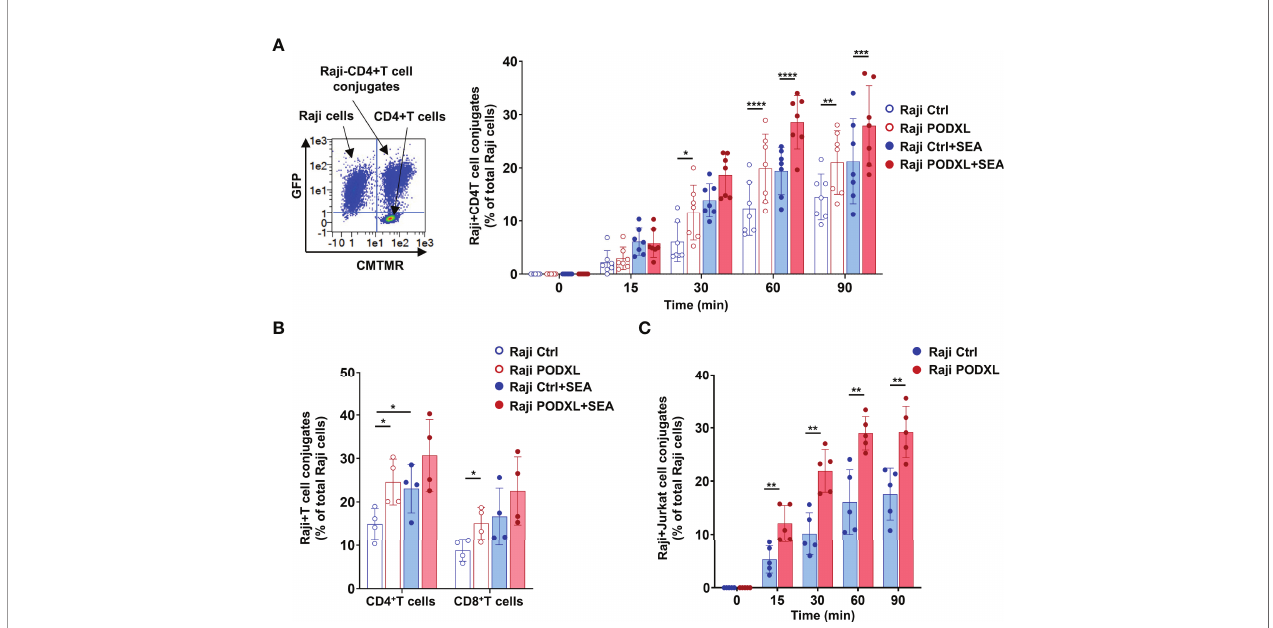
FIGURE 4 | PODXL expressed in APCs enhances both APC-CD4 + T cell and APC-CD8 + T cell interactions. (A) Raji cells overexpressing PODXL (red) or Raji-Ctrl cells (blue) were pulsed or not with SEA. Afterwards, CD4 + T cells isolated from PBMCs and pre-labelled with CMTMR were mixed with Raji-PODXL or Raji-Ctrl at a ratio of 1:1 and incubated for different time points at 37°C. The formation of conjugates between Raji cells (GFP + ) and CD4 + T cells (CMTMR + ) was detected as CMTMR + and GFP + events by fl ow cytometry. A representative density plot out of seven independent experiments is shown. Graph shows mean ± SD of the percentage of conjugates (CMTMR + GFP + ) from the total Raji cells (GFP + ) of four independent experiments. *p < 0.05, **p < 0.01, ***p <0.001, ****p < 0.0001, two- way ANOVA. (B) Raji-PODXL or Raji-Ctrl cells were mixed with isolated CD4 + T and CD8 + T at a ratio of 1:1 and incubated for 30 min. CD4 + and CD8 + T cells were detected using anti-CD4-APCH7 and anti-CD8-APCH7 monoclonal antibodies by fl ow cytometry. The percentage of Raji-CD4 + T cell (GFP + APCH7 + ) or Raji-CD8 + T cell (GFP + APCH7 + ) out of the total Raji cells was determined. Bar graph represents the mean ± SD of fi ve independent experiments. *p < 0.05, RM one-way ANOVA. (C) Raji-PODXL or Raji-Ctrl cells were mixed with CMTMR-labeled Jurkat cells at a ratio of 1:1 and incubated at different time points. The percentage of Raji-Jurkat cell conjugates was determined by fl ow cytometry as in (A) . Bar graph represents the mean ± SD of fi ve independent experiments. **p < 0.01, two-way